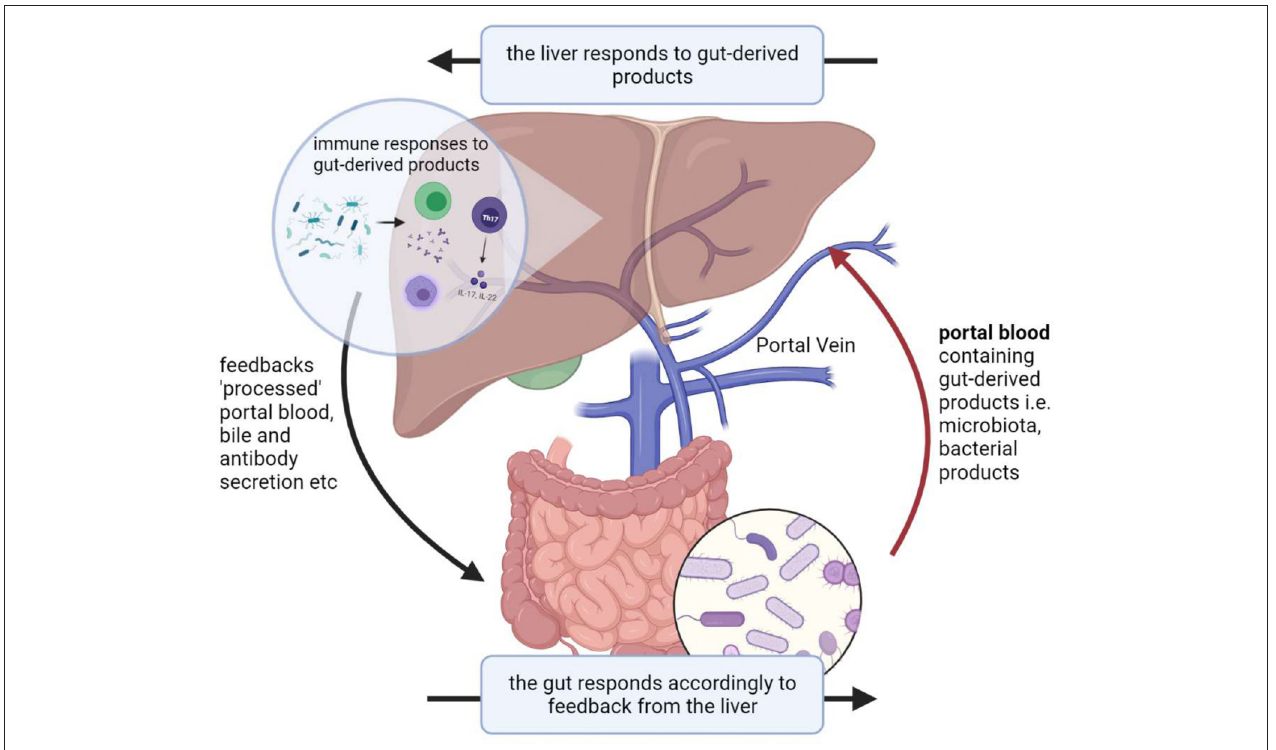
FIGURE 1 | Illustration of the gut-liver